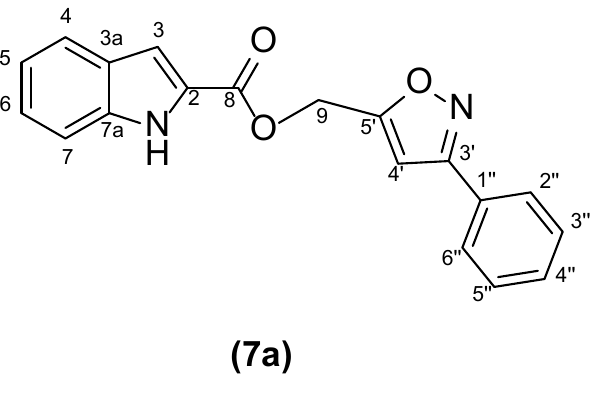
Figure 4: structure and numbering of compounds (7a) and (8a)